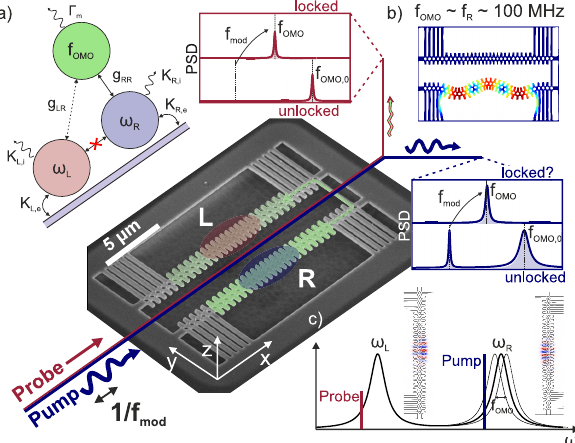
Figure 1: Optomechanical system and detection